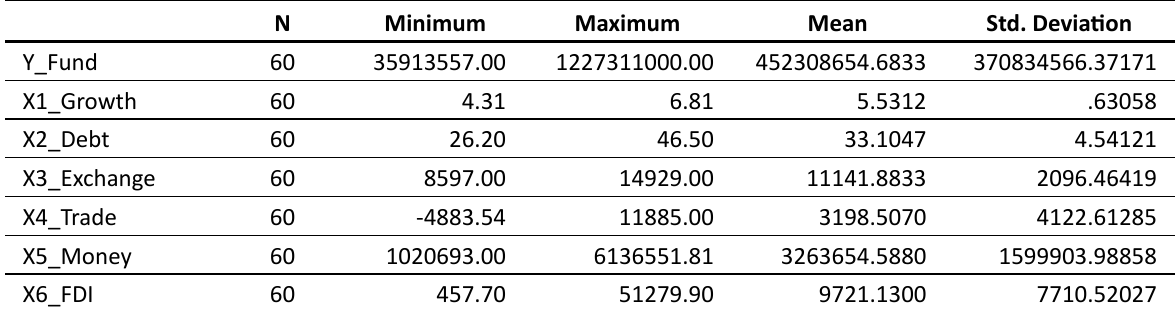
T able 2: Descriptive Statistics Test Result